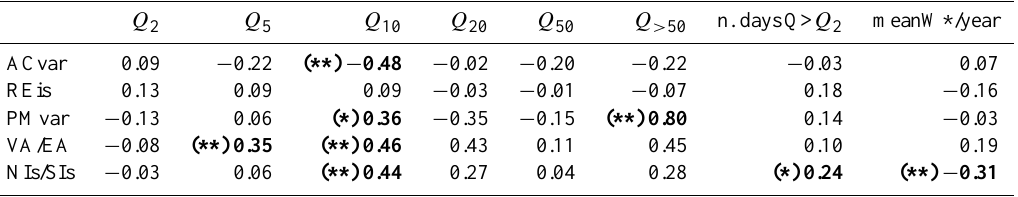
Table 4. The values of Spearman’s correlation rho ( ρ) between the landscape metrics and control factors: the number of months since the last flood, for all studied return periods ( Q 2 to Q > 50 ) , the number of days at which the water flow was higher than the Q 2 discharge (n. daysQ> Q 2 ) and the sediment availability (meanW*/year). Landscape variable acronyms are listed in Table 2. All landscape variables, excepted REis, are related with the number of months since the last Q 10